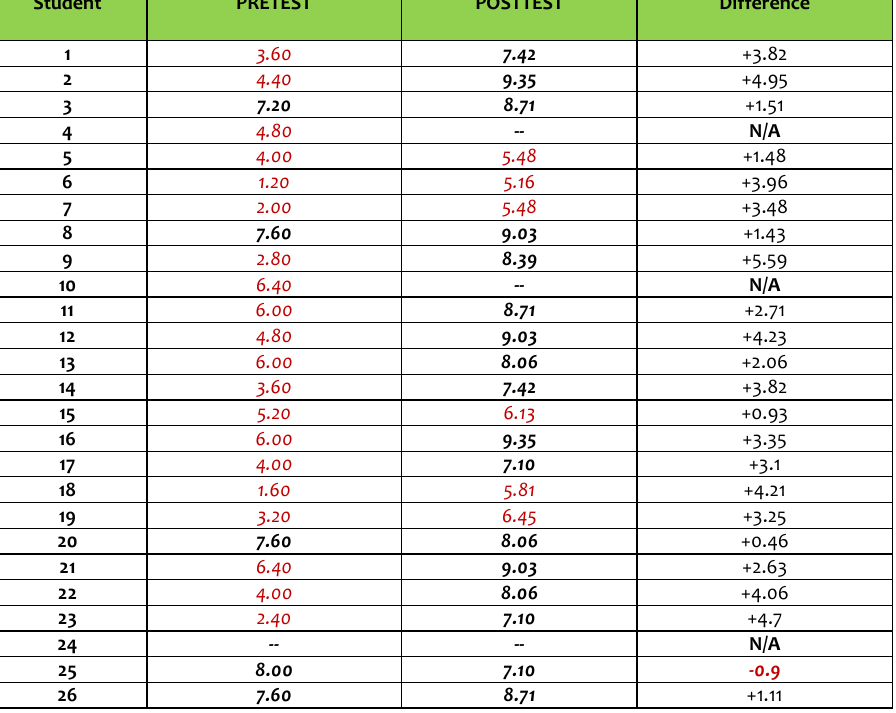
Table 6. Comparison of Results in Both